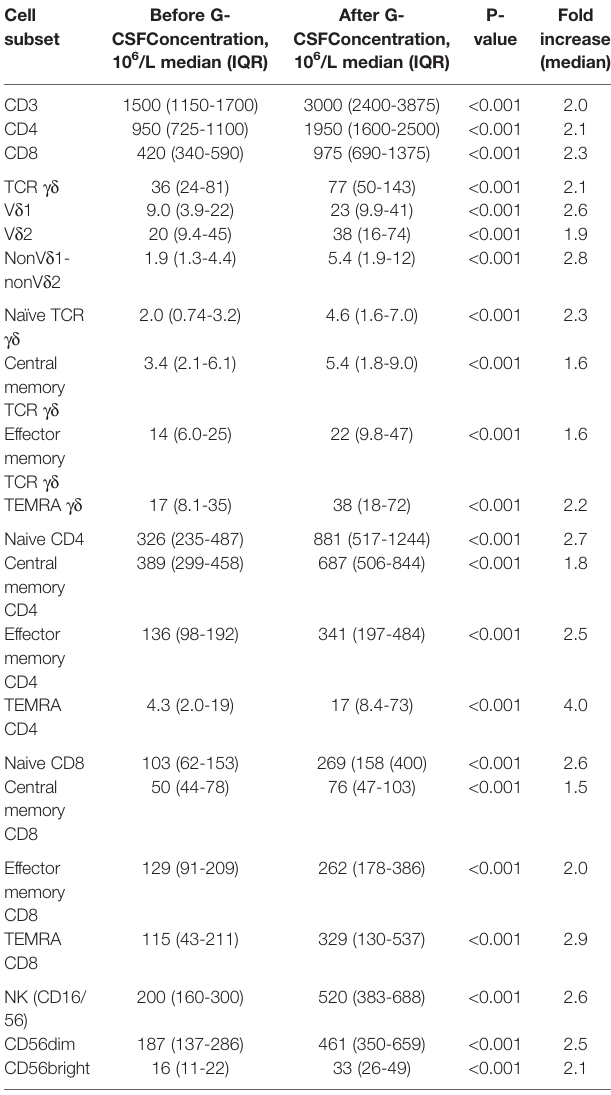
TABLE 1 | Lymphocyte subset concentrations before and after G-CSF stimulation in peripheral blood of healthy donors, n=49. Cell Before G- subset